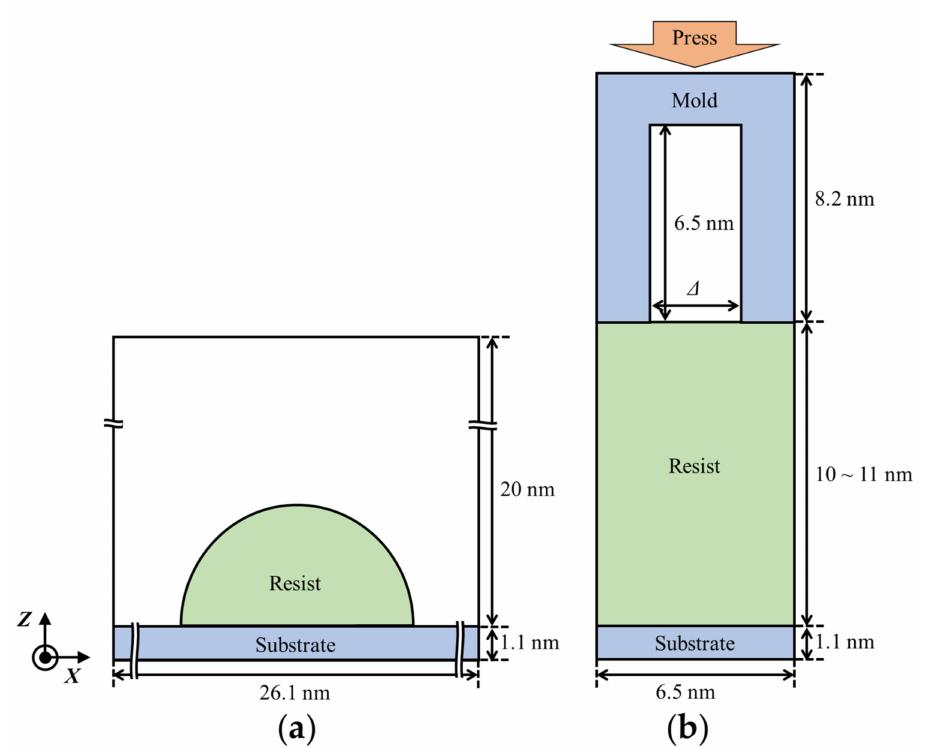
Figure 2. Schematics of the simulation systems for ( a ) contact angle estimation and ( b ) resist filling process. The box size along the y -direction was 5.4 nm for both systems. Mold and substrate were modeled with silicon atoms. The trench width ∆ in ( b ) was 2.17 or 3.26